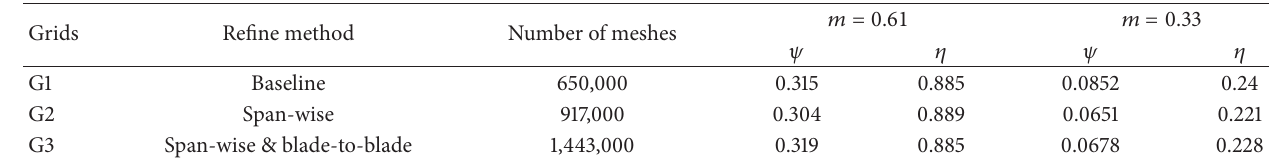
Table 2: Grid independence